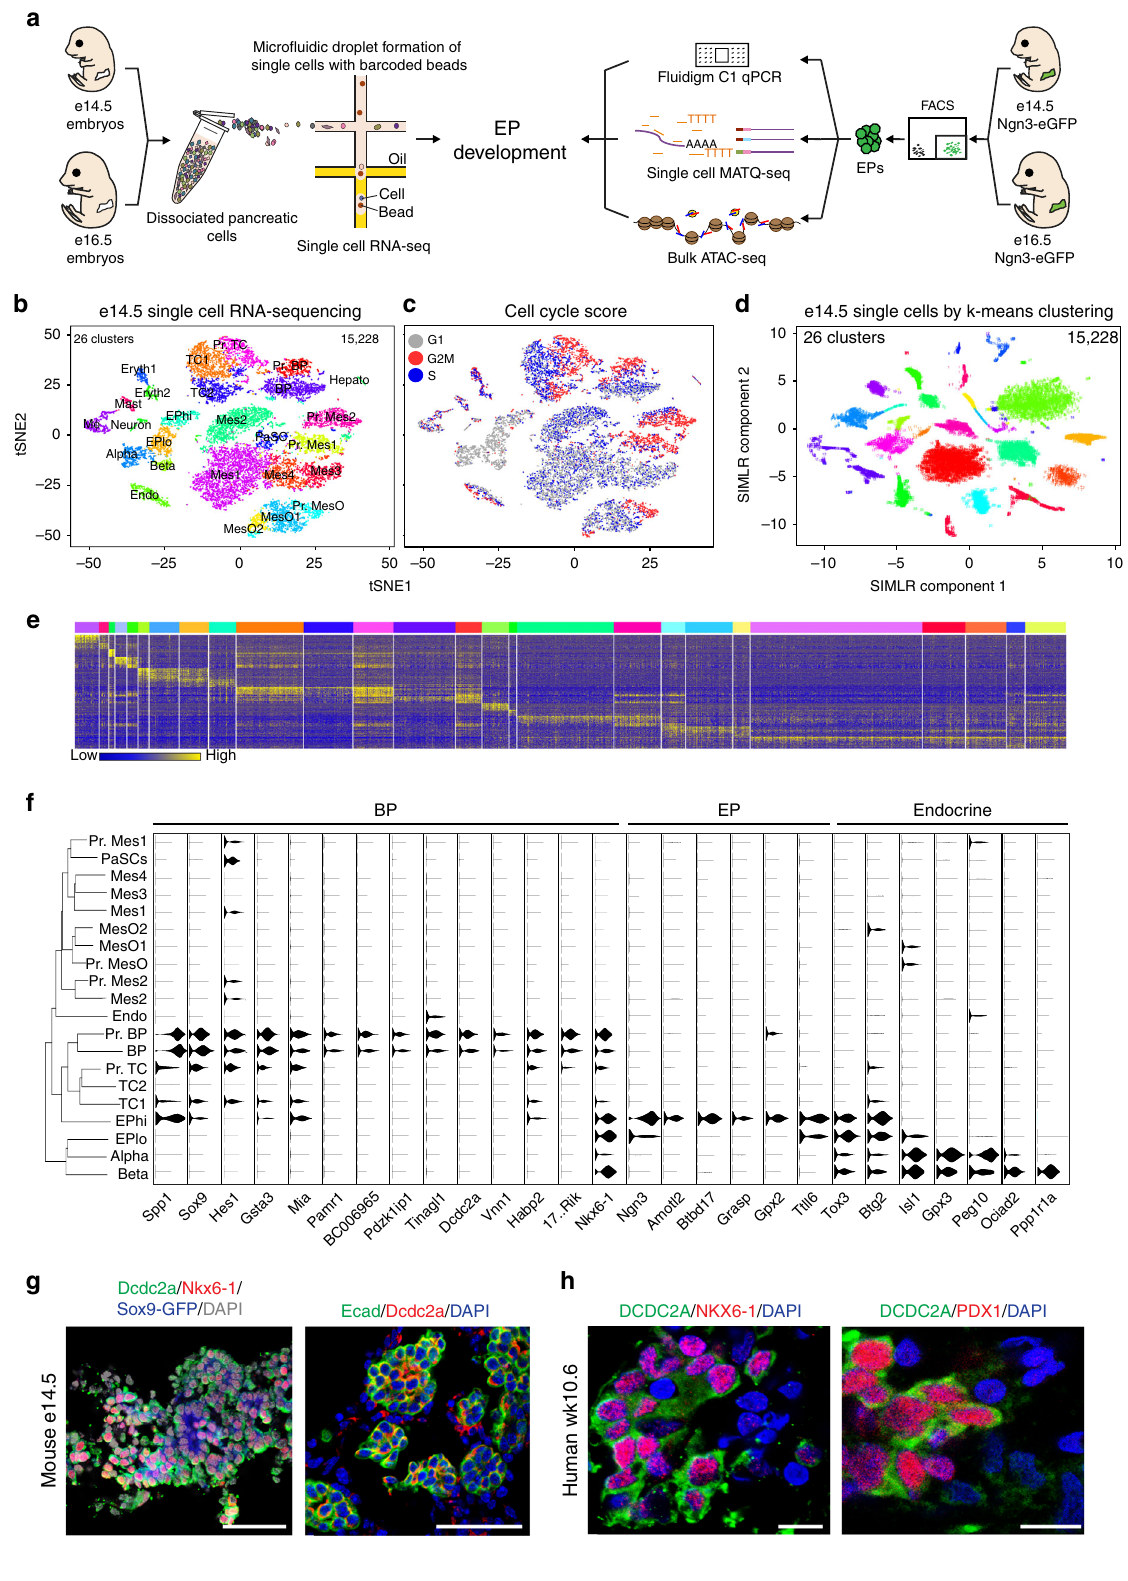
found a higher number of alpha cells (30.8% of endocrine cells) than beta cells (11.3% of endocrine cells; Supplementary Fig. 3a). Hierarchical clustering showed EPlo cells in close association with alpha and beta cells, while EPhi clustered with BPs and tip cells, suggesting that EPhi precede EPlo cells, which then differentiate